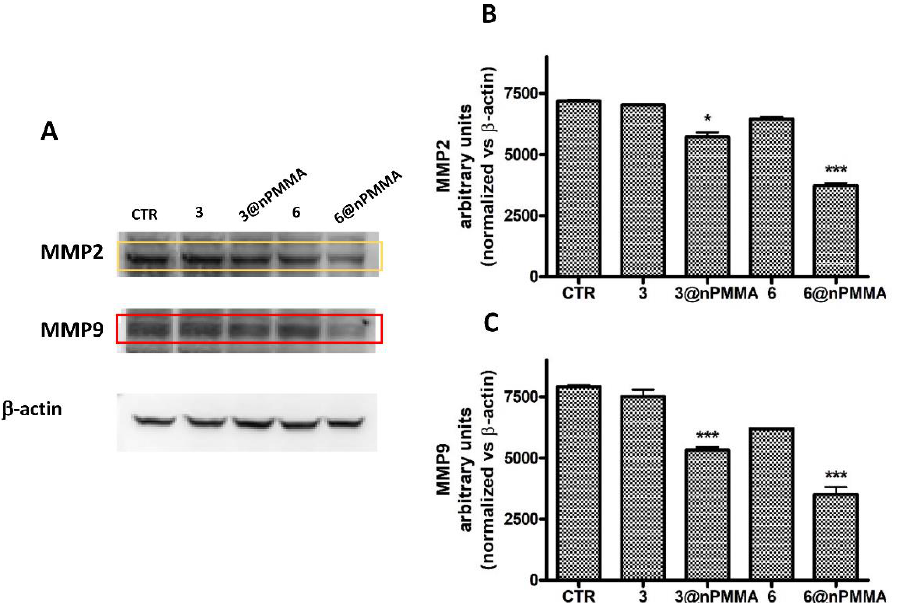
Figure 7. MMP2 and MMP9 protein levels and densitometric analysis in SKOV3 cells treated 24 h with subtoxic concentrations (IC 20 ) of 3 , 3@nPMMA , 6 and 6@nPMMA , irradiated for 1 h and incubated for 24 h in a drug free medium at 37 °C. ( A ) Representative western blotting images for MMP2, MMP9 and β -actin protein levels. Densitometric analysis of MMP2 ( B ) and MMP9 ( C ) performed for all the experiments. The results were normalized vs. β -actin protein levels (* p < 0.05, *** p < 0.001 vs. CTR and free BODIPY).